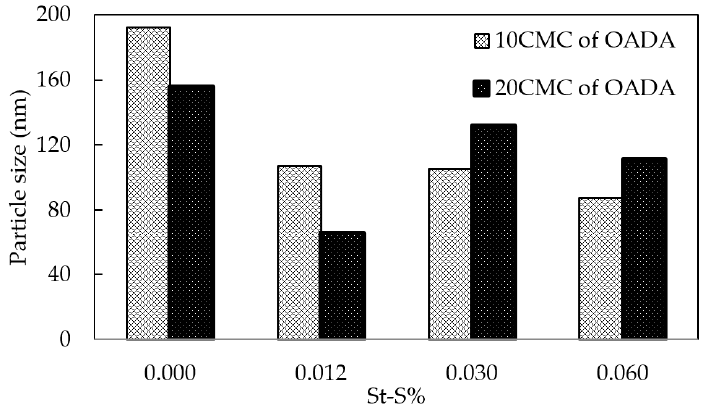
Figure 9. Influence of St-S content on SPSNP particle size prepared with di ff erent OADA concentrations: 10CMC and